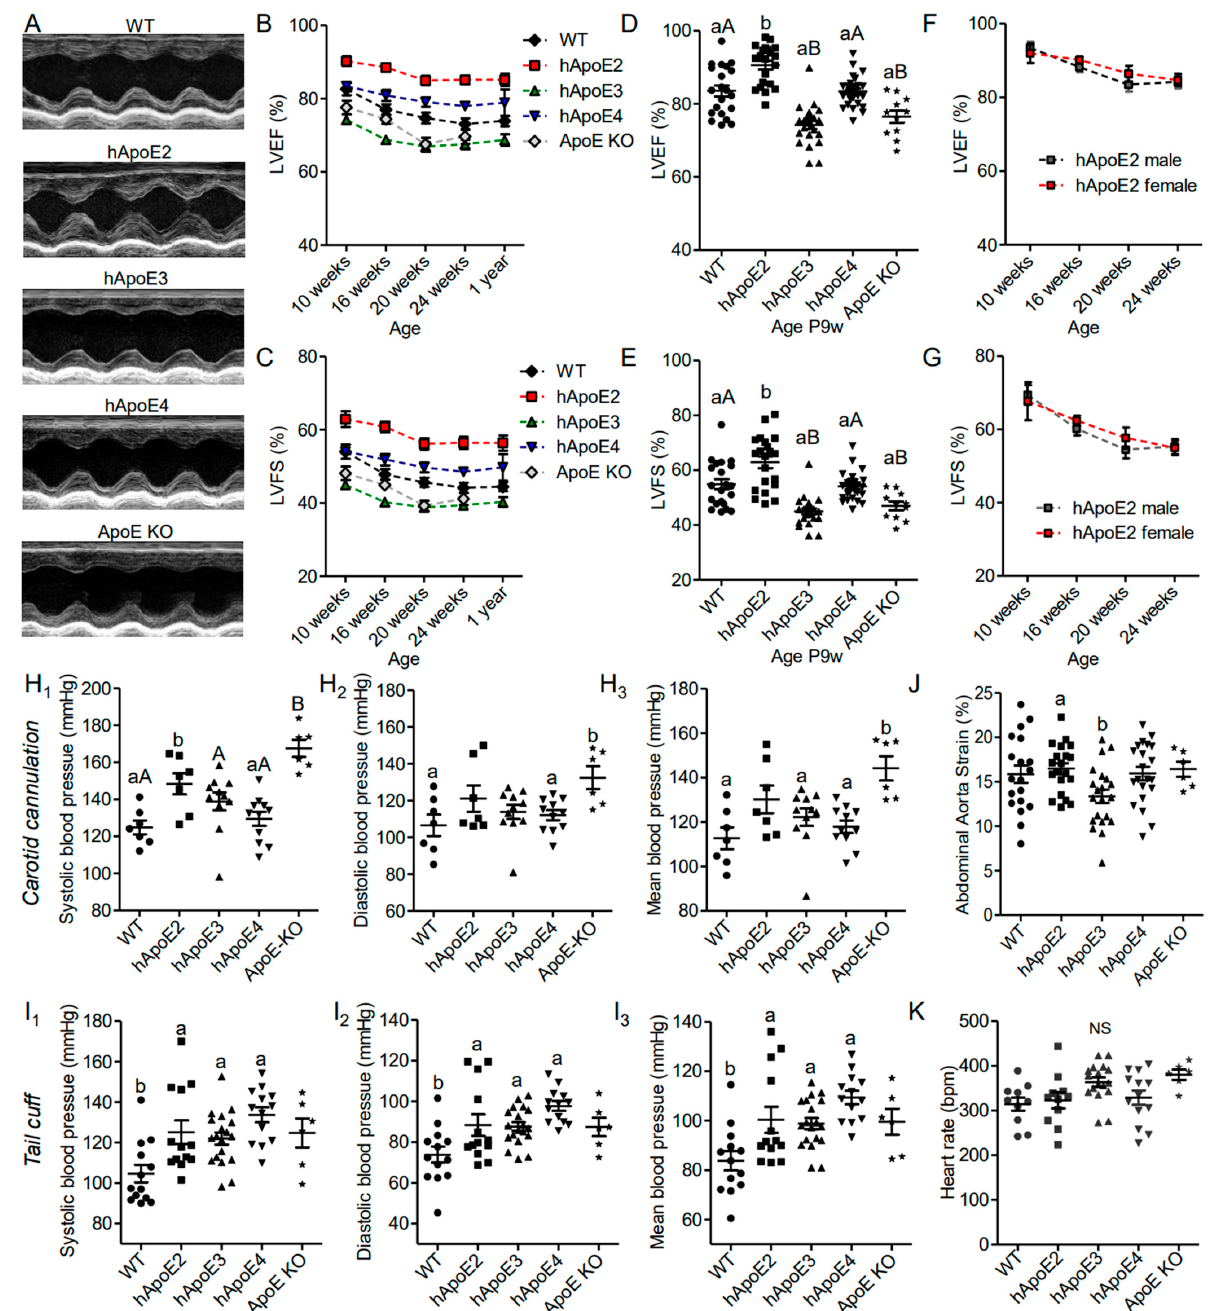
Figure 1. hApoE2 rats showed enhanced heart function, which influenced the diastolic blood pressure of the carotid artery but not distant tail blood pressure. ( A ) Heart function of different rats was measured and compared by M-mode echocardiography. ( B – E ). Left ventricular ejection fraction (LVEF, ( B , D )) and left ventricular fractional shortening (LVFS, ( C , E )) measured by echocardiography were compared between different male rats at different ages. ( F , G ). LVEF and LVFS of male and female hApoE2 rats were compared. ( H ). Blood pressure was detected through arterial cannulation of the left carotid artery in rats under anesthesia. ( I ). Blood pressure measured with a tail-cuff technique (CODA ® Noninvasive Blood Pressure System) was compared between awake rats. ( J ). Arterial strain measured in the abdominal aorta of different rats was compared. ( K ). Heart rate of different rats under awake condition. One-way ANOVA followed by a Tukey post hoc test. a vs. b, A vs. B, p < 0.05, NS, no significant difference. Rat number was indicated by symbols in the